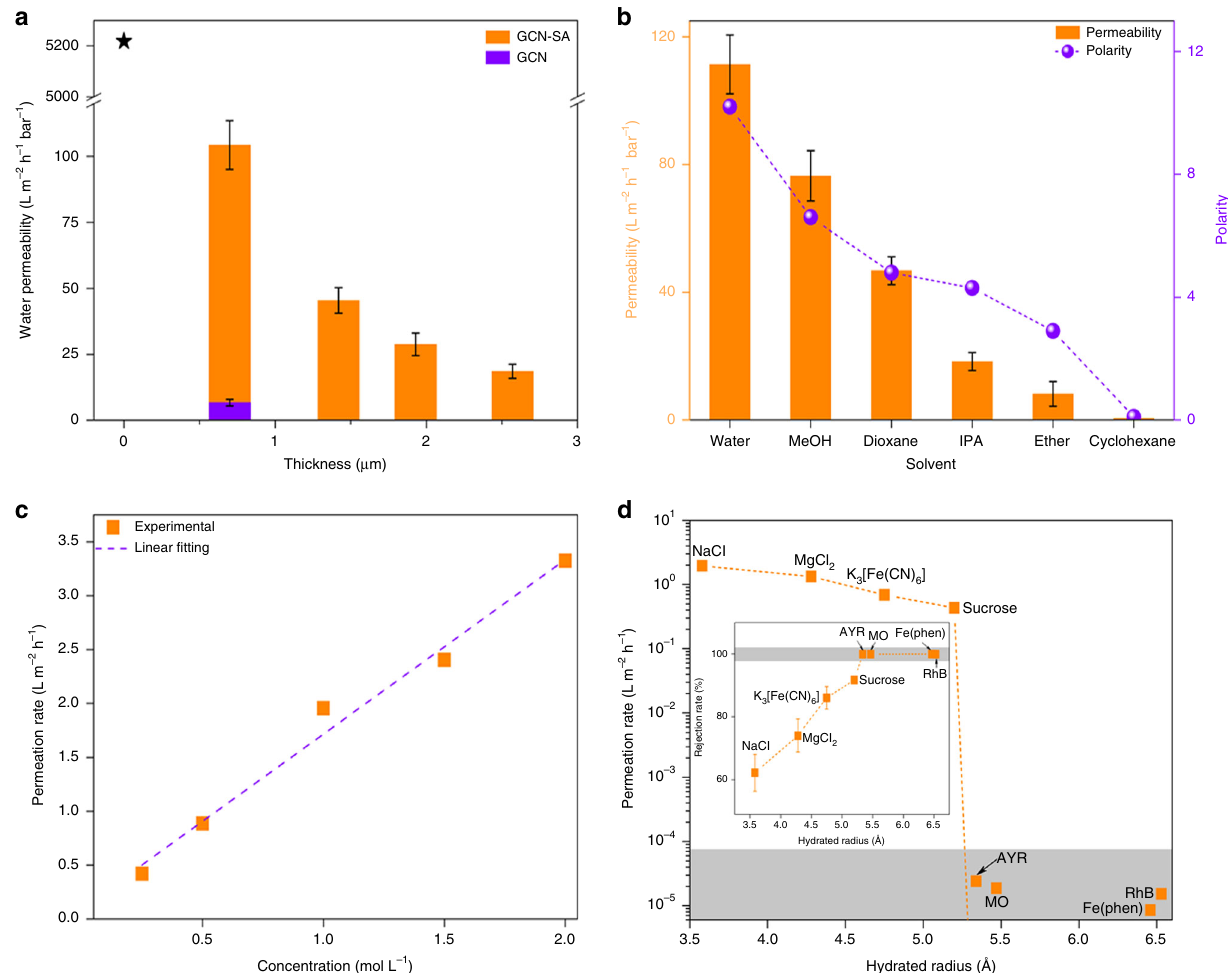
Fig. 3 Solvent permeability and sieving performance of GCN-SA membranes. The permeability, rejection rates and permeation rates are calculated according to Eqs. 1, 2 and 3, respectively. a Thickness-dependent water permeability of GCN-SA membranes fabricated by varying the volume of GCN-SA nanosheet suspension. The violet column shows the water permeability over GCN membrane fabricated by vacuum fi ltration of 25 mL GCN nanosheet suspension. The black star gives the water permeability over blank MCE substrate for comparison. b Permeability of various solvents over 700-nm thick GCN-SA membrane against solvent polarity. The dotted violet line and violet balls denote the polarity of different solvents. c The permeation rate as a function of initial NaCl concentration at feed compartment using 700 nm-thick GCN-SA membrane. The dotted violet line corresponds to the linear fi tting result of permeation rates. d Sieving performance of varied solutes through 700 nm-thick GCN-SA membrane. Inset: corresponding rejection rates against hydrated radii of these solutes. The dotted orange lines denote the permeation rates and rejection rates (inset) of different solutes as a function of their hydrated radii. All the error bars represent the standard deviation from three experimental data. (Fe(phen) [Fe(phen) 3 ]Cl 2, AYR alizarine yellow R, MO methyl orange, RhB rhodamine